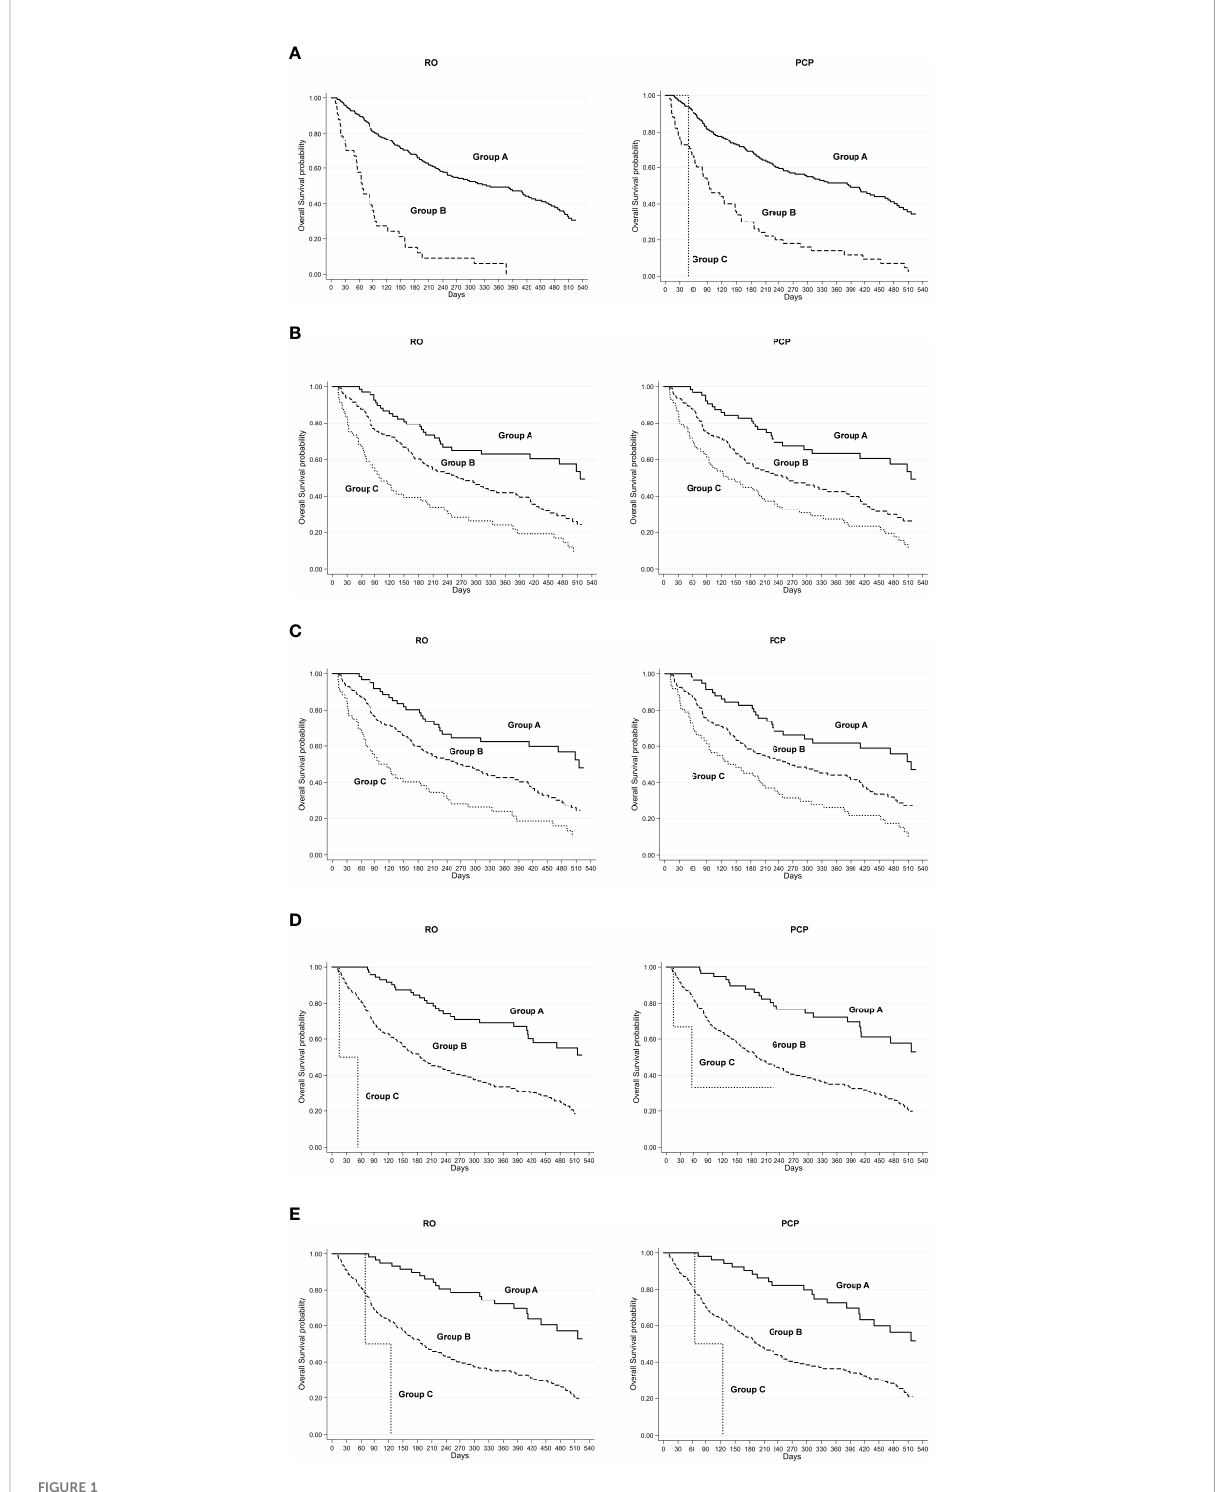
FIGURE 1 RO, radiation oncologist; PCP, palliative care physician; Kaplan – Meier overall survival curve for low-risk (group A), intermediate-risk (group B), and high-risk (group C) groups de fi ned by (A) PaP score, (B) SPS score (PSM), (C) SPS score (NRF), (D) TEACHH score (PSM), and (E) TEACHH score